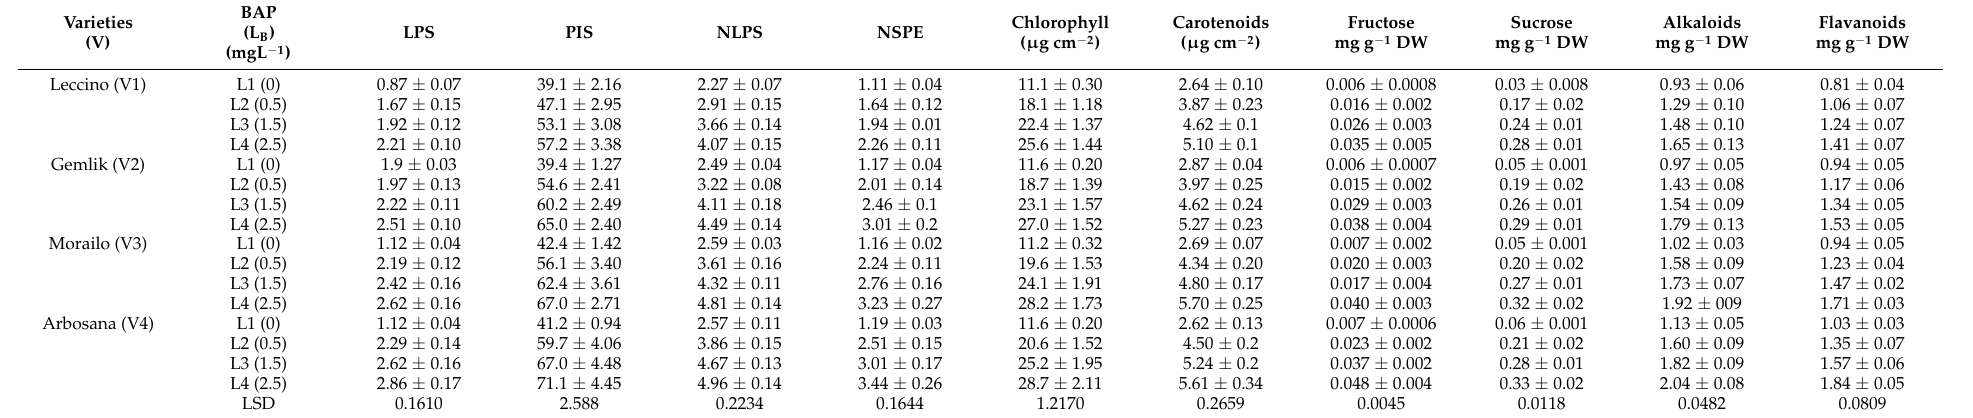
* Only traits showing significant difference are indicated in table, while means with difference greater than LSD are significantly different at p ≤ 0.05. (LPS, length of primary shoot; PIS, percentage of induced shoots; NLPS, number of leaves per shoot; NSPE, number of shoots per explant). Table 6. Traits showing statistically significant ( p ≤ 0.05) difference due to interaction effect of varieties and BAP concentrations (V × L B